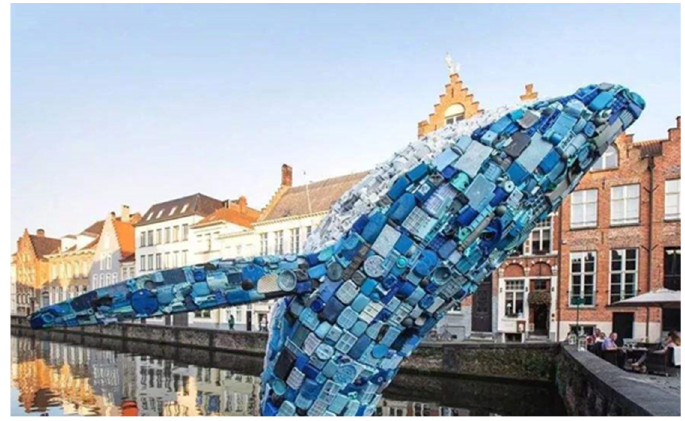
Figure 4. Public artwork “Whale”.